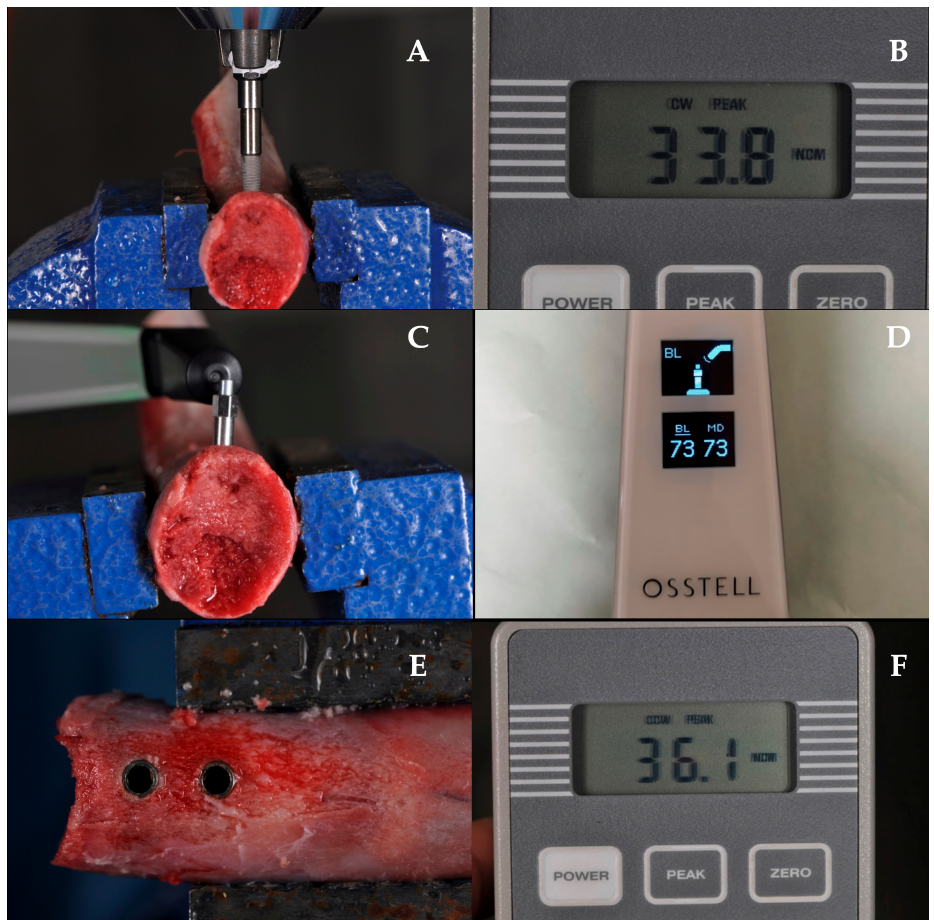
Figure 2. Primary implant stability analysis: Dental implant placement and recording of peak insertion torque (PIT) ( A , B ); measurement of implant stability quotient (ISQ) with a no-contact technique enabled by the magnetic waves produced by the Osstell ® Beacon ( C , D ); fixtures placed and recording of peak removal torque (PRT) ( E , F ).